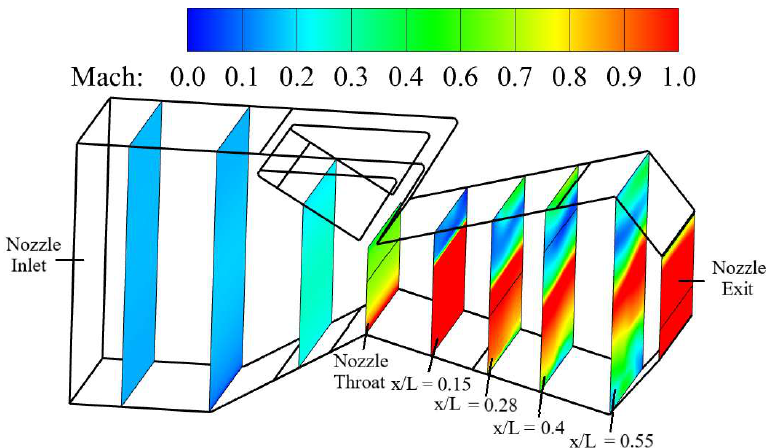
Figure 7. Mach contours obtained for different X/L planes.